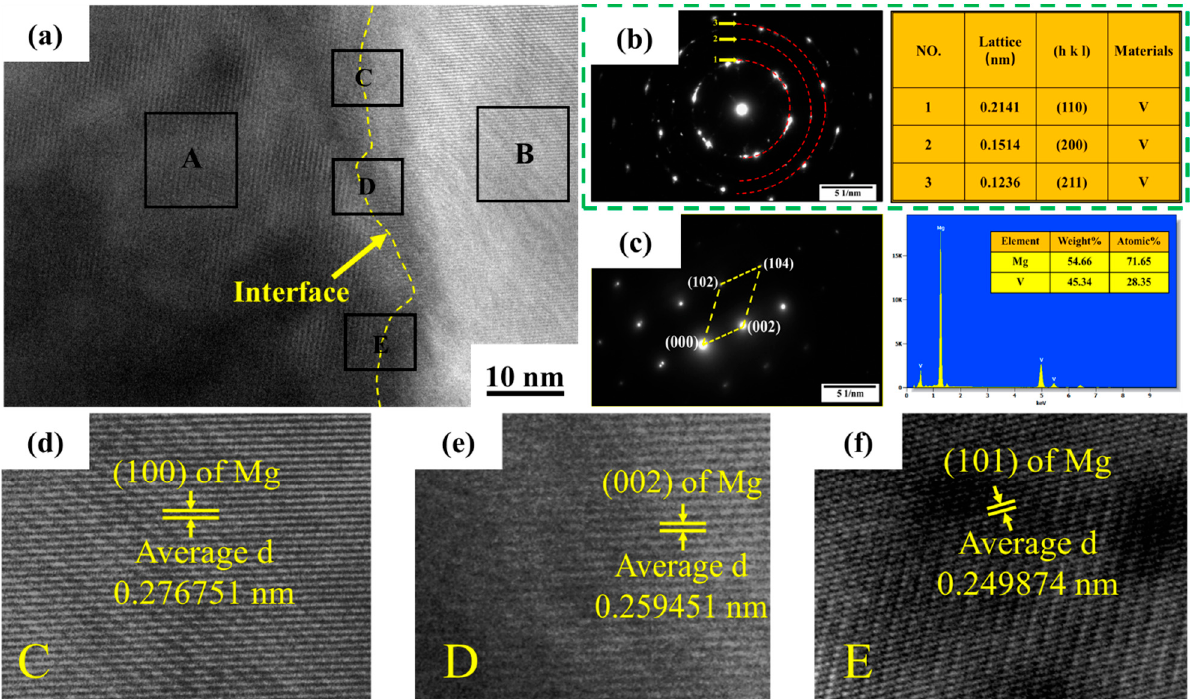
Figure 9. The interfacial structure of AZ31-5 wt % V P powders after milling for 90 h. ( a ) HRTEM image, ( b ) SAED pattern of V (region A) and its corresponding crystal parameters, ( c ) SAED pattern of Mg matrix (region B) and EDX result of region D, ( d – f ) is the measured d -spacing of regions C, D and E.